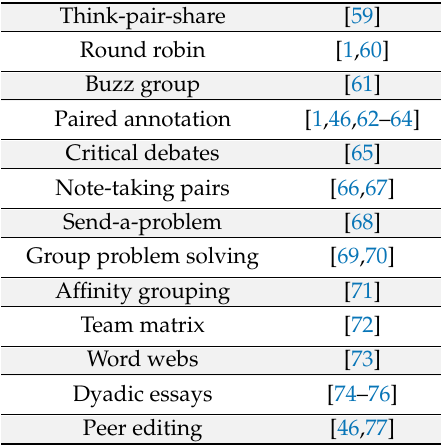
Figure 3. Type and percentage of adopted CoLTs in collected papers. Table 7. Examples of adopted CoLTs and corresponding references